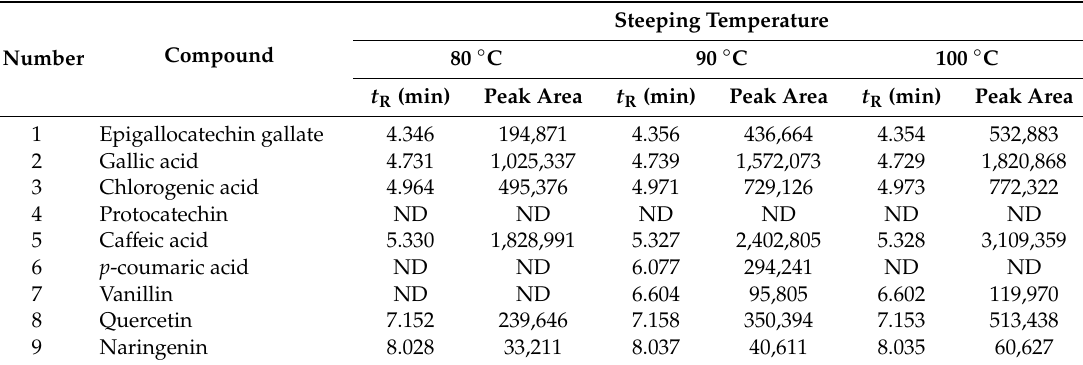
Table 5. Phenolic composition of infusions obtained from flowers and leaves of Cunila polyantha dried at 70 ◦ C for 2 h and prepared at di ff erent steeping temperatures (80, 90, and 100 ◦ C) identified by high-performance liquid chromatography (HPLC-PDA).